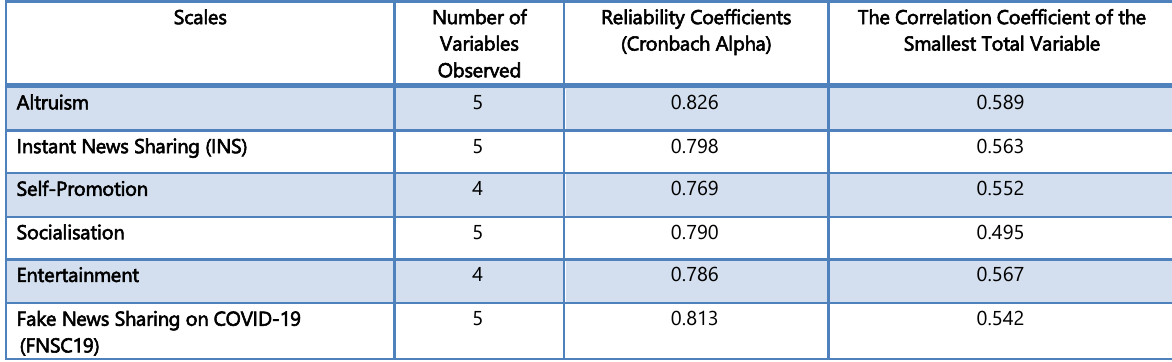
Table 2: Summary of Reliability and Relative Minimum Variables of Scales (Source: Authors’ calculations) Scales Number of Reliability Coefficients The Correlation Coefficient of the Variables (Cronbach Alpha) Smallest Total Variable Observed Altruism 5 0.826 0.589 Instant News Sharing (INS) 5 0.798